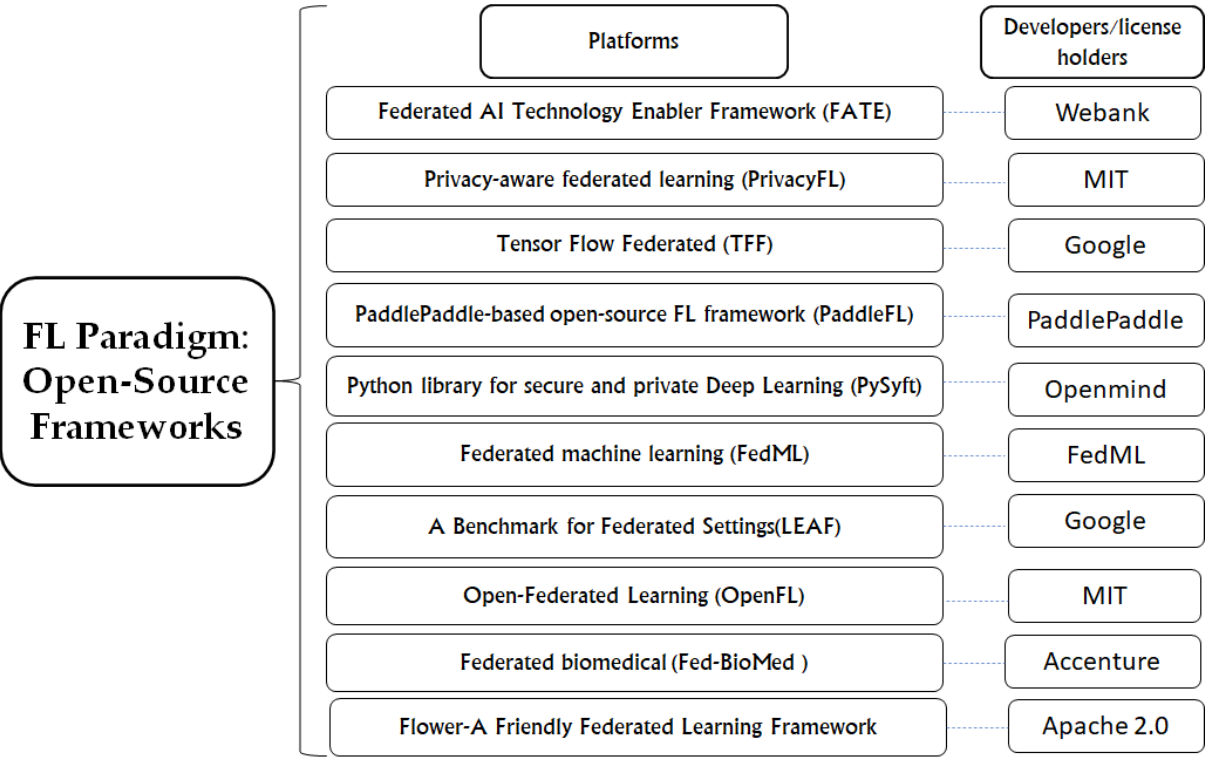
Figure 6. Open-source implementations of the FL paradigm (i.e., open source FL